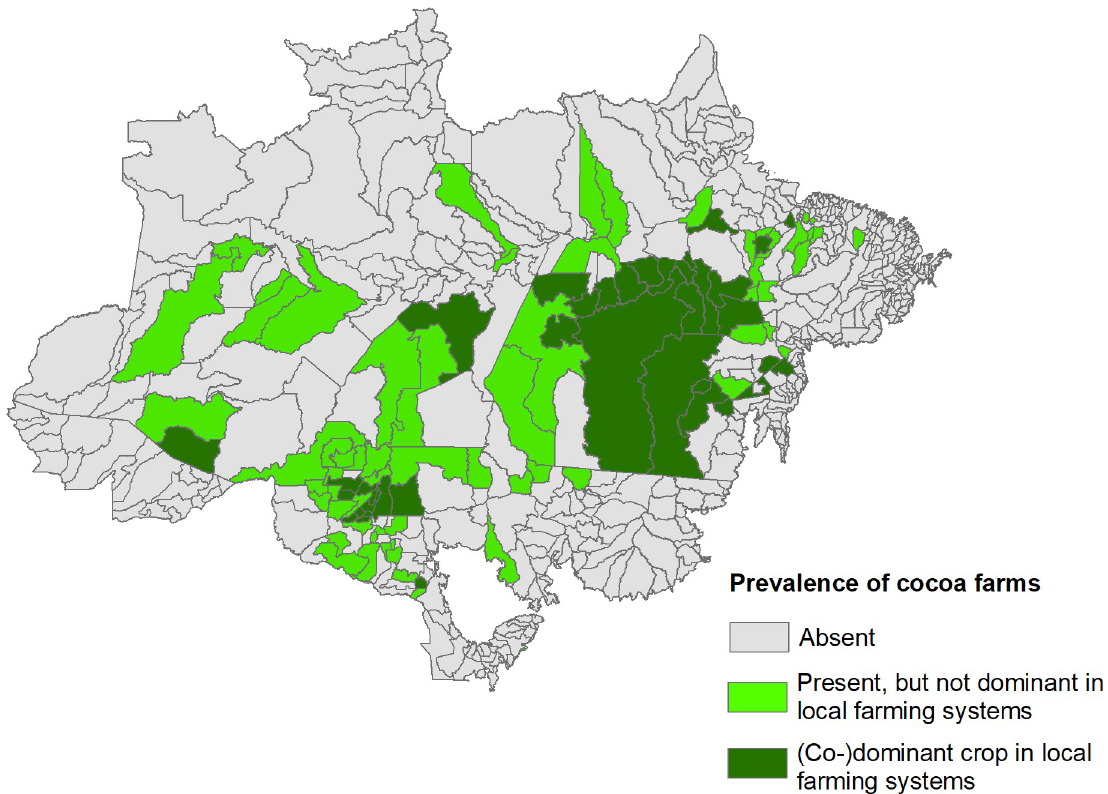
Fig 1. Spatial distribution of the prevalence of cocoa